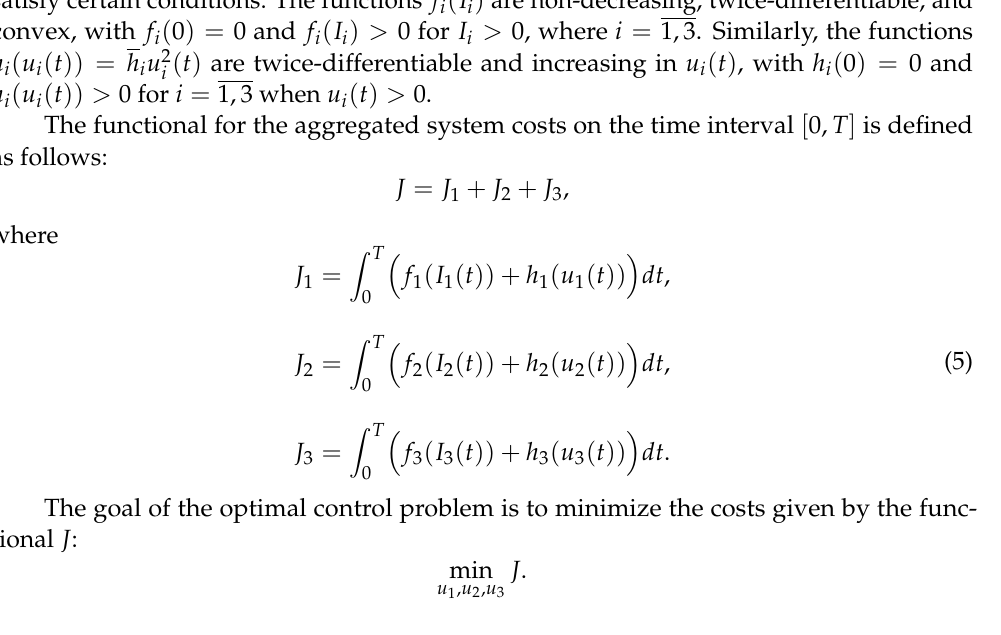
= m 32 = m 21 = E E S